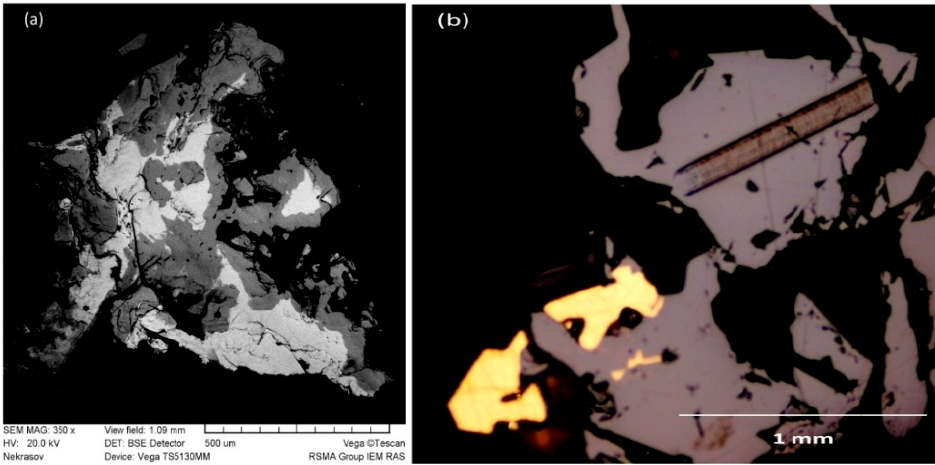
Figure 38. The internal structure of the synthesised crystals of sphalerite (polished sections). ( a ) In-